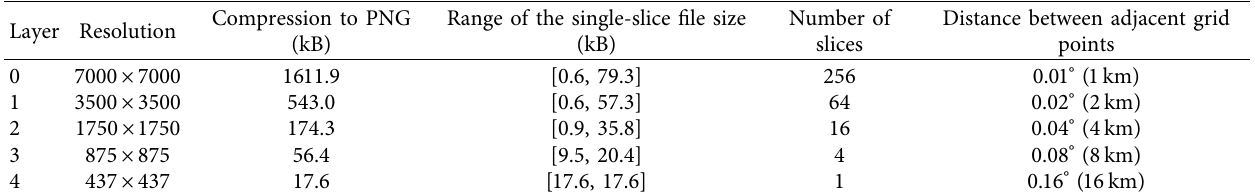
Figure 4: The area relation between the visible screen range and the diagonal width of each layer. Table 1: Slices after